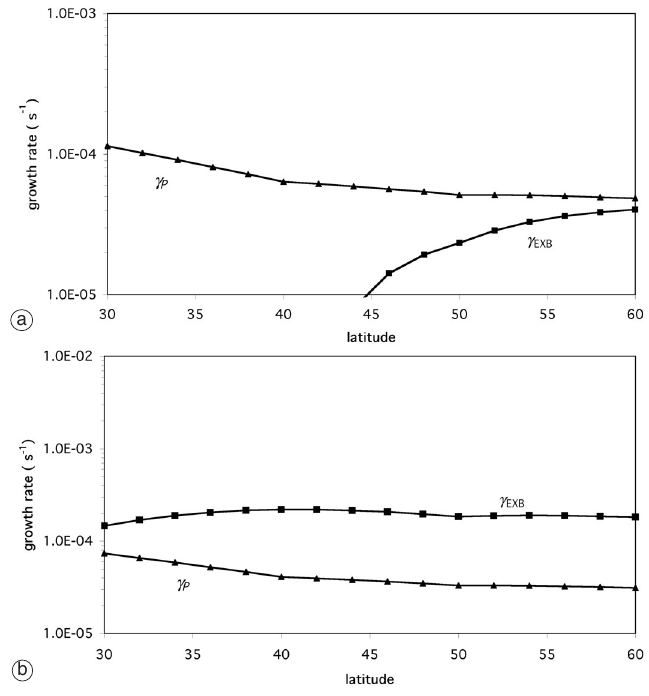
Fig. 12.9a,b. Latitudinal variation of the instability and the Perkins